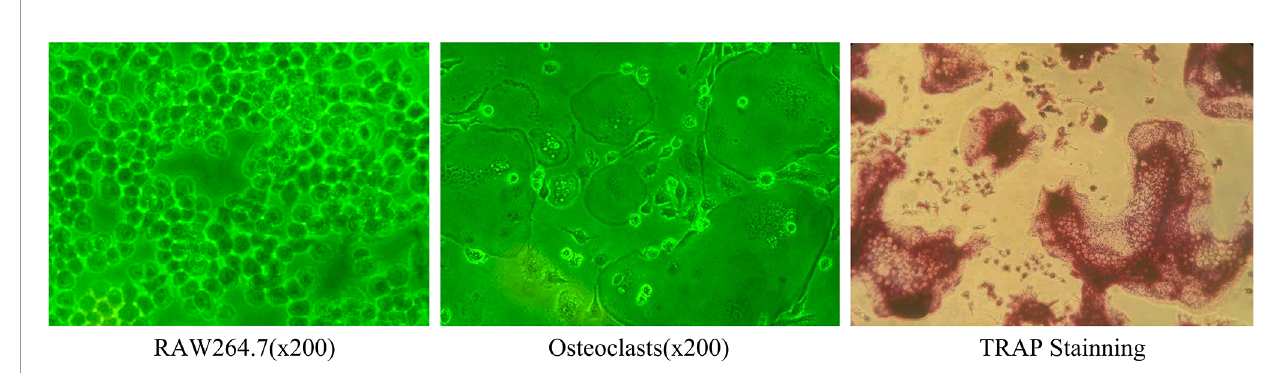
FIGURE 1 | Under light microscope, RAW264.7 cells were round and mononuclear in shape and became osteoclasts after 5 days induction. At this time, the cells were large and multinuclear in shape, were surrounded by unfolding fold margin. TRAP staining was positive (Inverted phase contrast microscope x200).